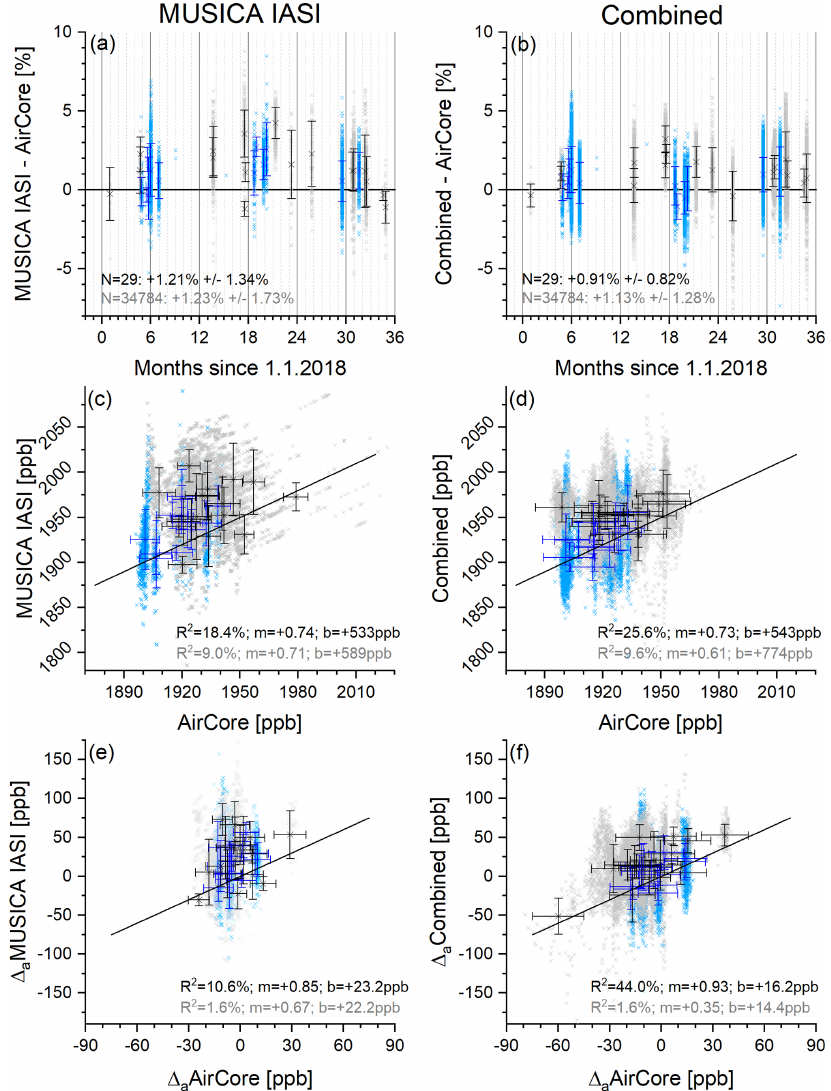
Figure 11. Same as Fig. 10 but for the comparisons of tropospheric partial-column-averaged CH 4 AirCore and satellite products (IASI and